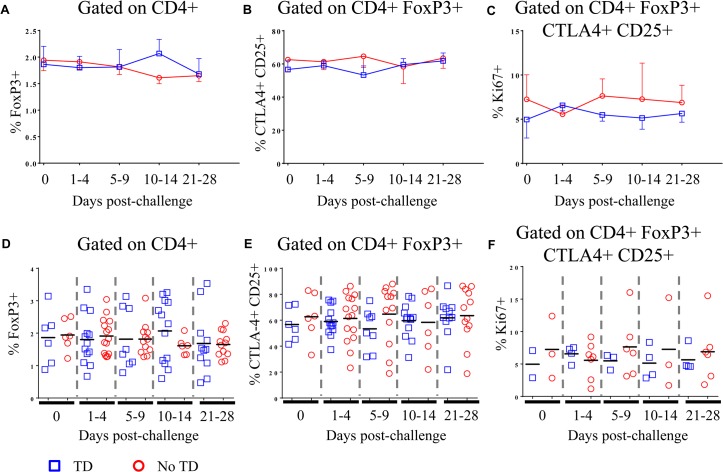
Percentages of circulating and proliferating Treg in TD and No TD volunteers.
A) Percentage of CD4+ T cells positive for FoxP3 expression and B) percentage of CD4+ FoxP3+ T cells positive for CTLA-4 and CD25 in PBMC obtained pre-challenge and at multiple time-points after challenge (TD n = 6; No TD n = 6). C) Percentage of CD4+ FoxP3+ CTLA-4+ CD25+ T cells expressing Ki67 (a marker of proliferation) ex vivo (TD n = 2, No TD n = 3). Values are shown as the mean +/- SEM. Scatter plots showing D) the percentage of CD4+ T cells positive for FoxP3 expression and E) the percentage of CD4+ FoxP3+ T cells positive for CTLA-4 and CD25 in PBMC obtained pre-challenge and at multiple time-points after challenge (TD n = 6; No TD n = 6). F) the percentage of CD4+ FoxP3+ CTLA-4+ CD25+ T cells expressing Ki67 (a marker of proliferation) ex vivo (TD n = 2, No TD n = 3). Means are indicated with a black horizontal line. P-values were determined using a mixed effects regression model. TD (blue squares); No TD (red circles). Values from multiple time-points were grouped together in time segments (1–4, 5–9, 10–14, and 21–28 days post-challenge) to account for variability in the samples available from each volunteer. Some volunteers had samples from multiple time-points in a time-segment resulting in more data points than the corresponding number of volunteers.